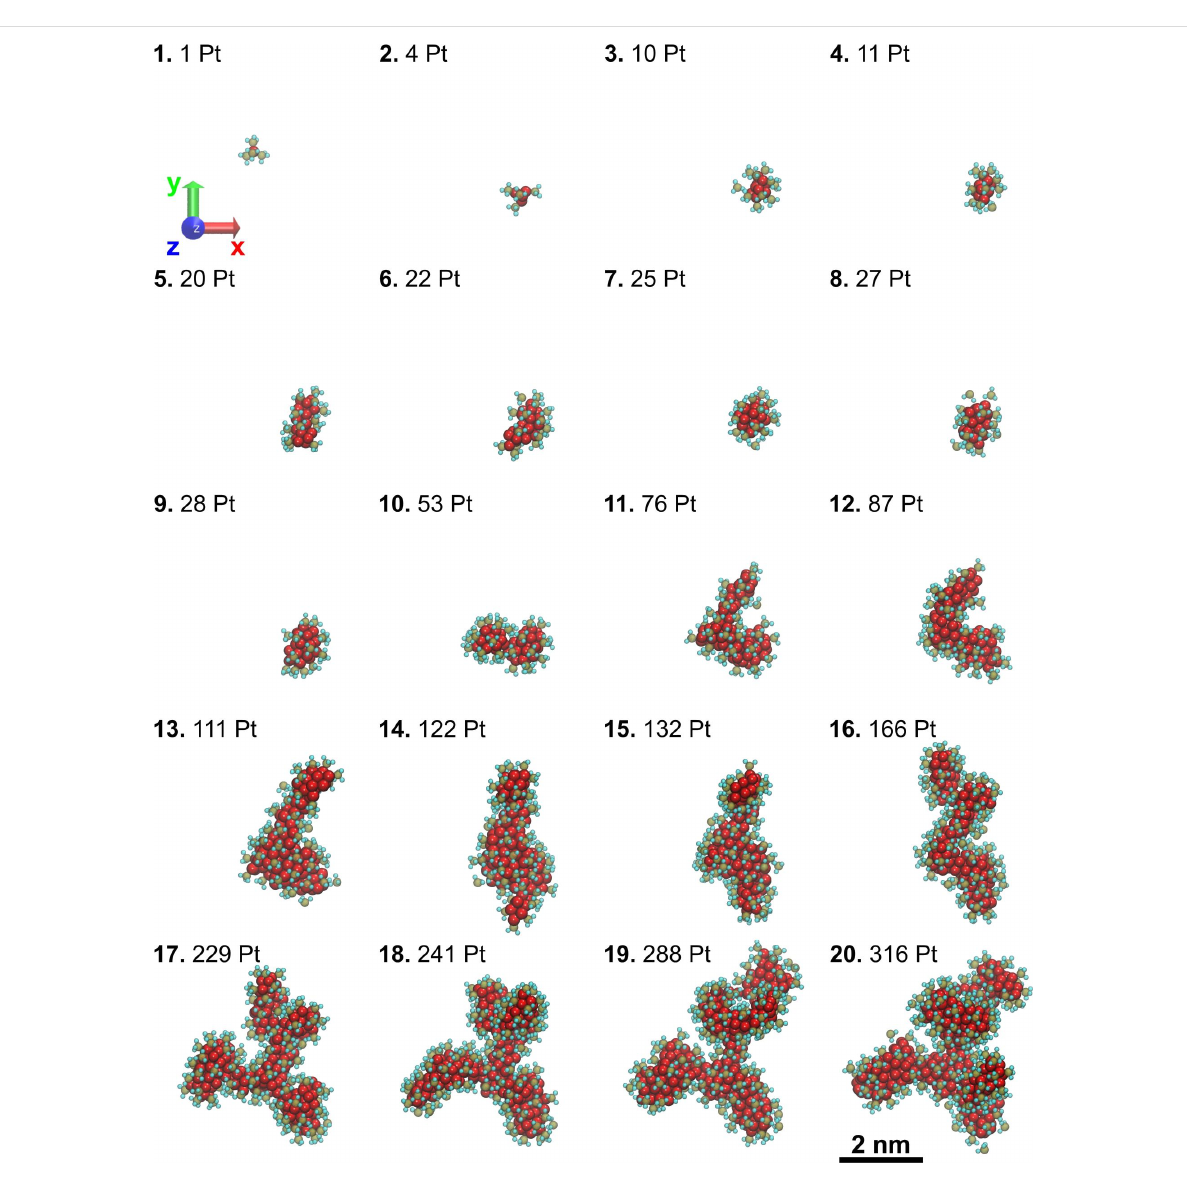
shape and tend to rearrange after an elongation caused by the merging of clusters of comparable size (see cycles 1–9).